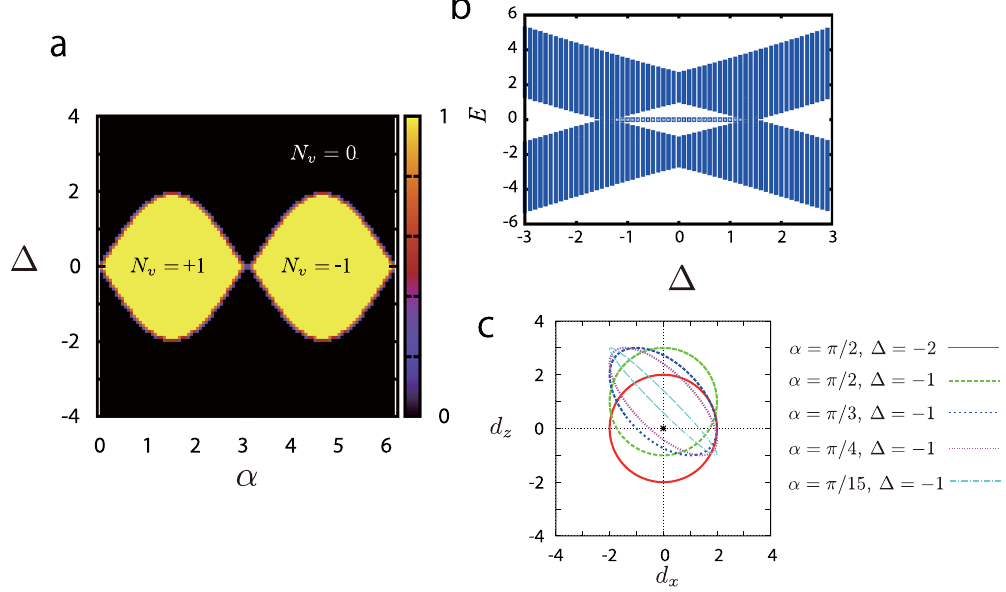
Figure 5. ( a ) Phase diagram of the 1D GWDM for θ a = θ b ± π , θ + = − θ − , and α ≡ θ − − θ a . The phase diagram has a similar structure to that of the Haldane model on a honeycomb lattice. Δ and α are free parameters. ( b ) Energy spectra with a zero-energy edge state at α = π /4. ( c ) Hamiltonian trajectories when sweeping k . = (0, 0) is the gap closing point in our θ a = θ b ± π , θ + = − θ − , and α ≡ θ − − θ a . ( d x , d z )